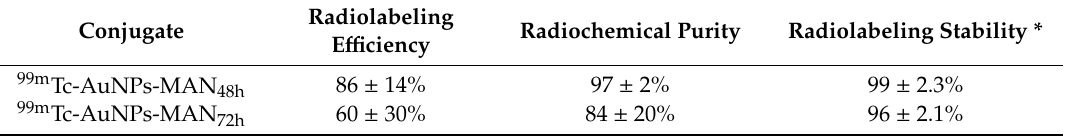
Table 2. Radiolabeling results.